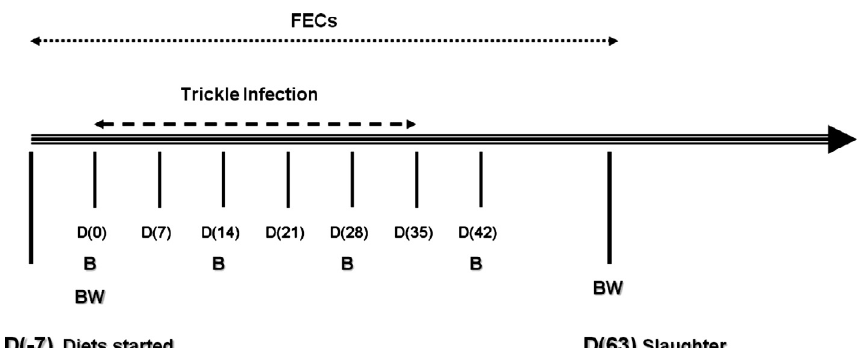
Figure 1. Experimental design: D(-7): animal distribution into feeding regime groups. D(0): start of a weekly trickle infection of H , contortus and T. colubriformis for 6 weeks D(7), D(14), D(21), D(28), D(35) and D(42). D(63): slaughter and necropsy of 8 male lambs par group. Measurements of BW: body weight were performed on D0 and D63, FECs: faecal egg counts (weekly) and B: blood sampling to measure PCV